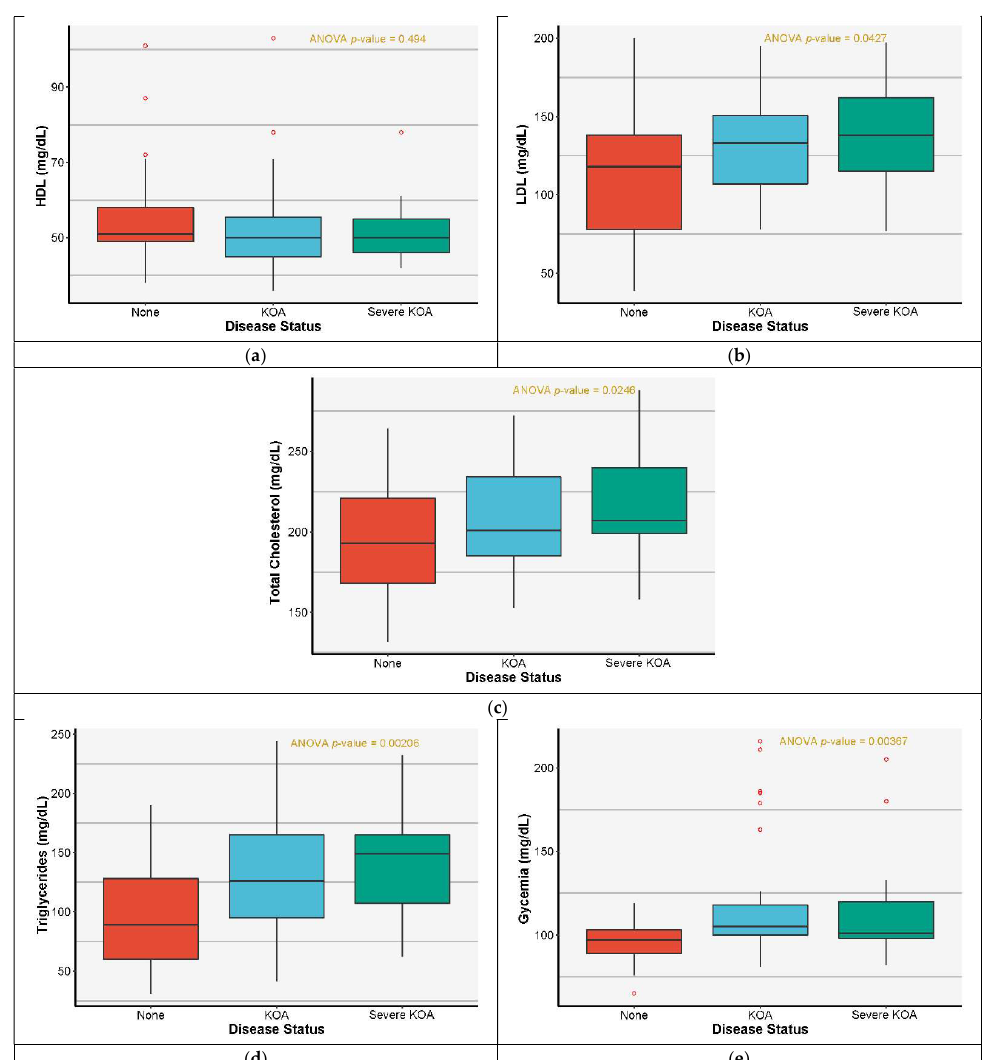
Figure 4. Distribution of patients’ MetS parameters values function of KOA severity with the associated ANOVA p -values ( a ) HDL distribution, ( b ) LDL distribution, ( c ) total cholesterol distribution, ( d ) triglycerides distribution, ( e ) glycemia distribution.